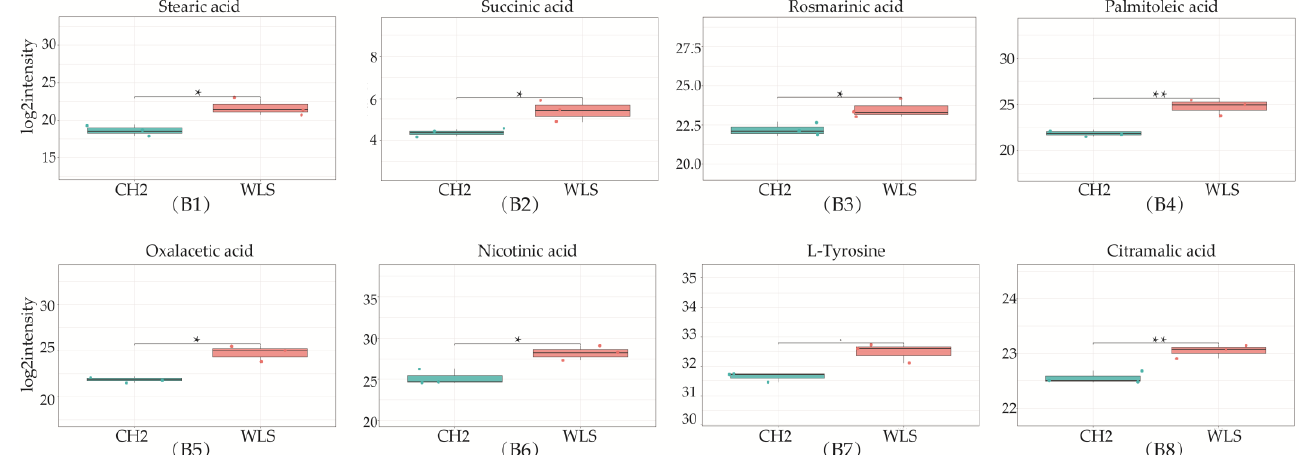
Figure 5. Differentially expressed metabolites in SYF in CH2 and WLS at 150 days. ( A1 – A10 ) Ten differential metabolites were identified ( p < 0.001 and p < 0.05); ( B1 – B8 ) Identified partial differential metabolites that may be associated with sexual maturity, * p < 0.05, indicates significance compared to the WLS group. ** p < 0.01, indicates extreme significance compared to the WLS group. ( p < 0.05 and p < 0.01). *** p < 0.001, indicating extreme significance compared to the WLS group.